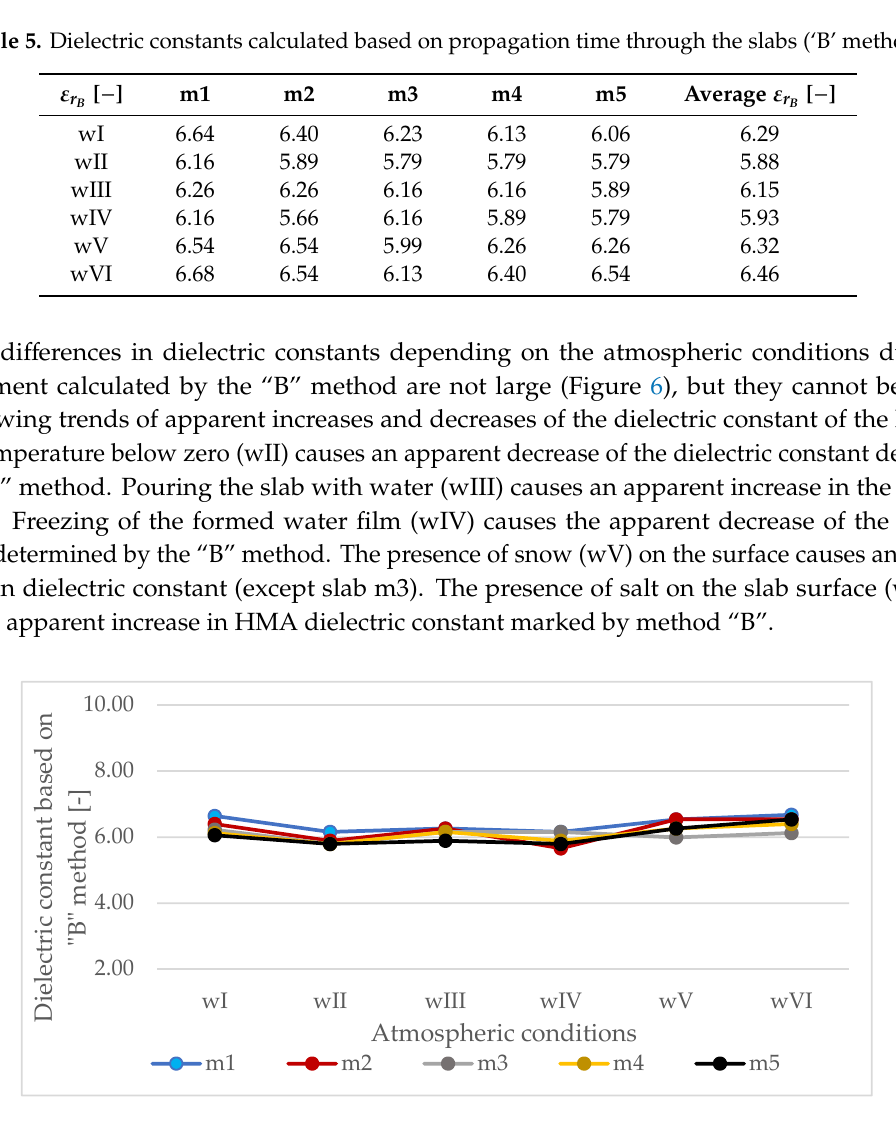
Figure 6. Dielectric constants calculated based on propagation time through the slabs (“B” method).